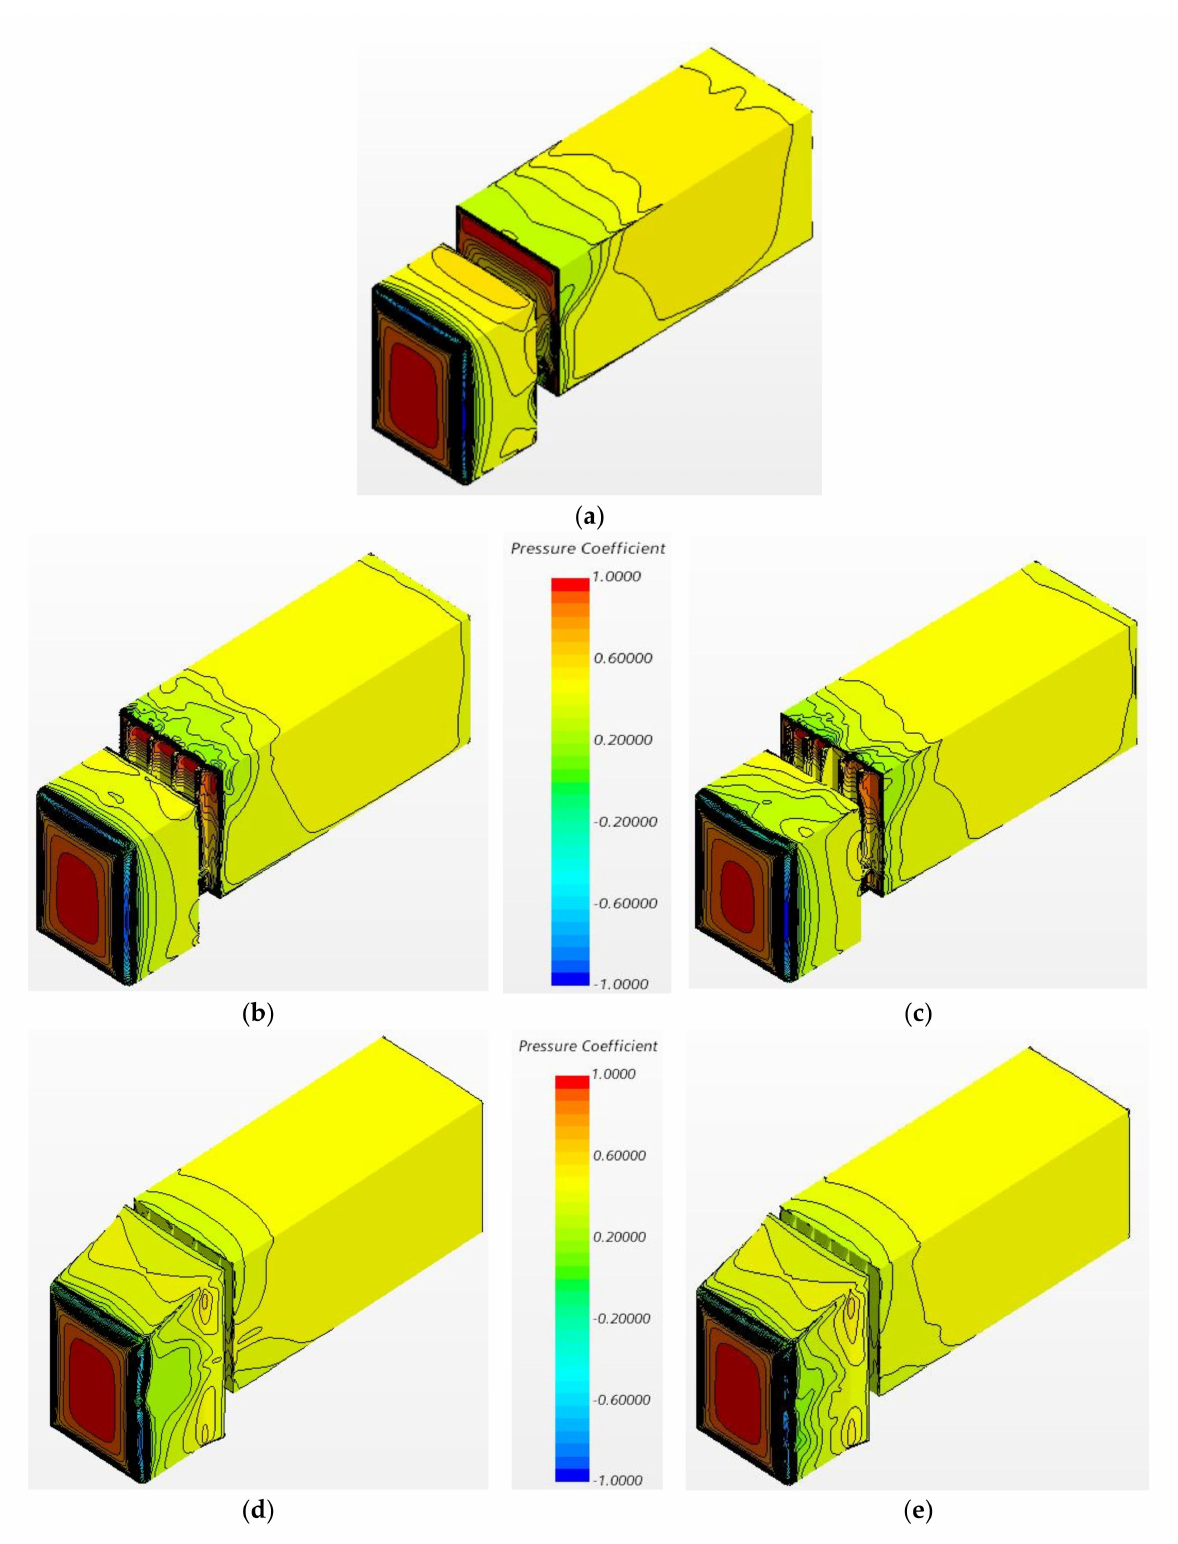
Figure 7. Contours of surface pressure coefficient: ( a ) baseline case; ( b ) Case 1; ( c ) Case 2; ( d ) Case 3; ( e ) Case